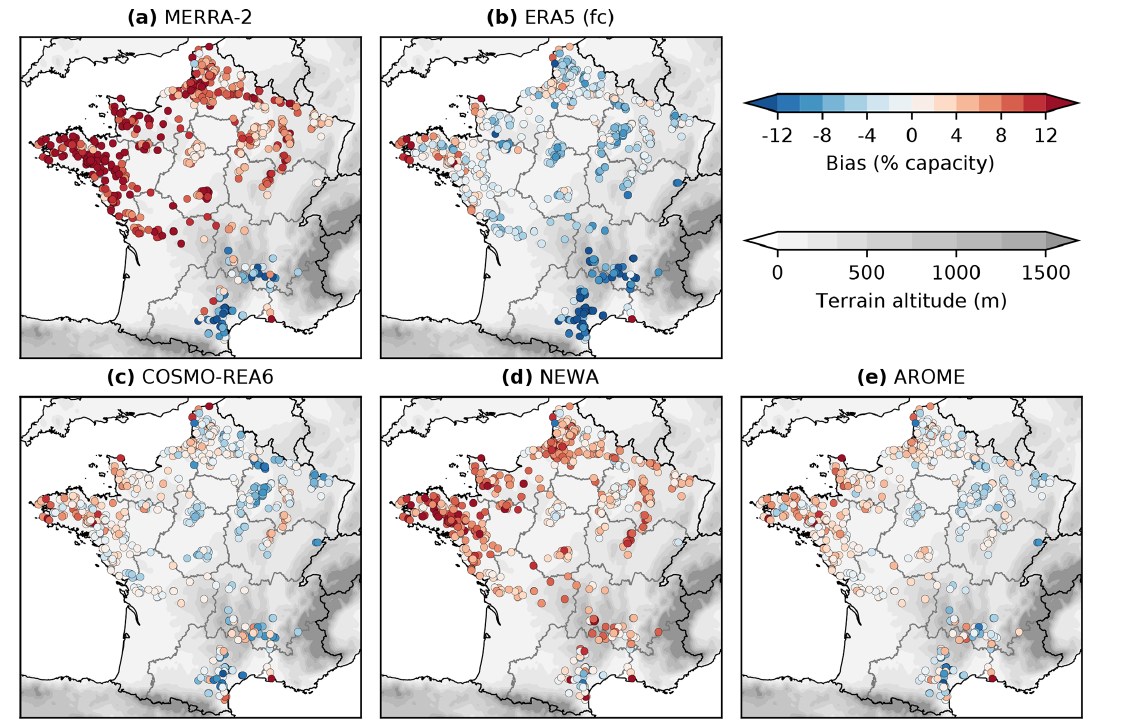
Figure 5. Local biases of wind-power production simulations based on MERRA-2 (a) , ERA5 (forecasts) (b) , COSMO-REA6 (c) , NEWA (d) and AROME (e) , compared to Enedis database at city scale. Bias (model – observation) in average power expressed in percent of the city installed capacity. Year 2015, loss factor of